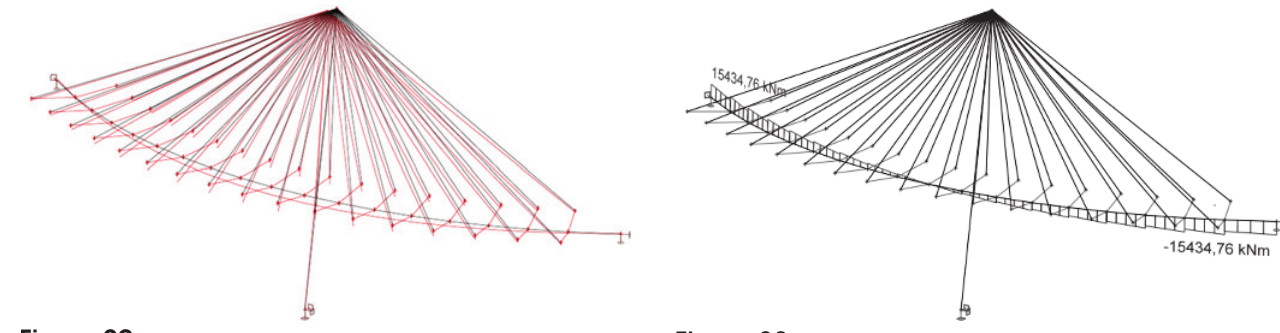
Figure 33 Torsional moment on curved deck (P+L): bilateral